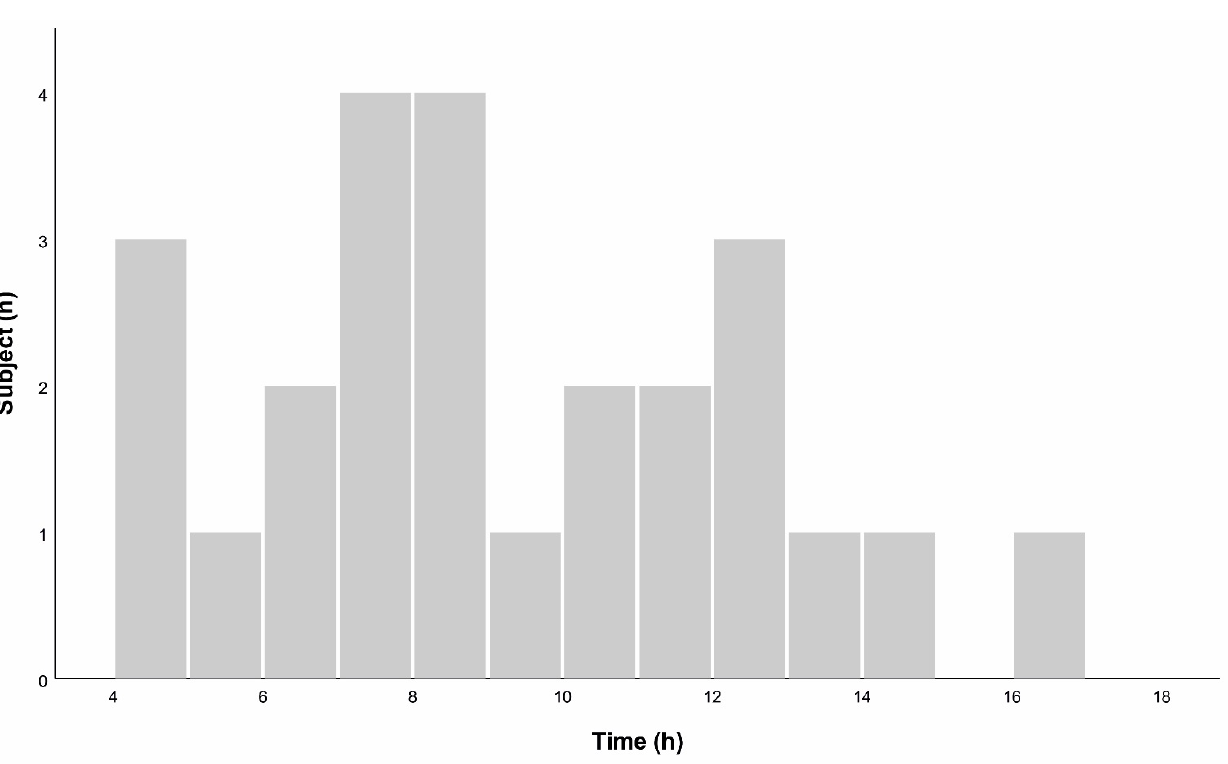
Figure 3. Time after gluten ingestion plotted against peak urinary gluten immunogenic peptides (GIP) concentration. x -axis: time in hours. y -axis: number of subjects.